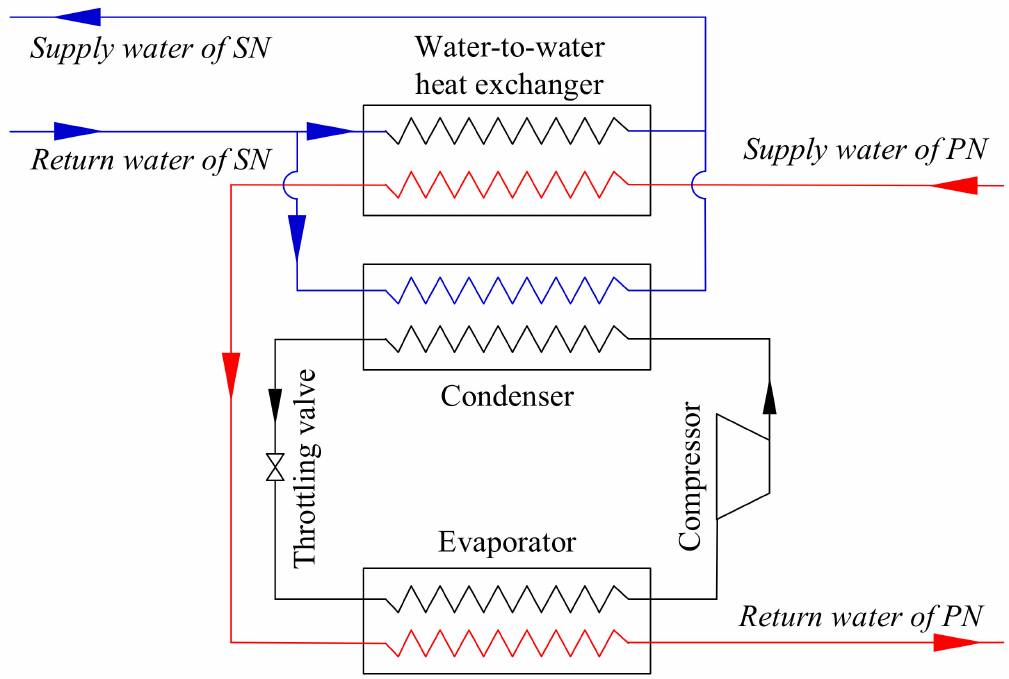
Figure 1. Sketch of new hybrid heat exchanger